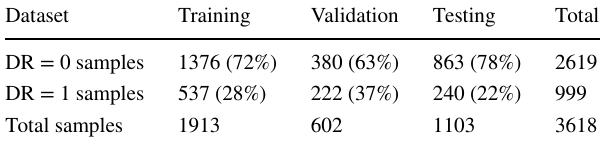
Table 1 Diabetic retinopathy patients data